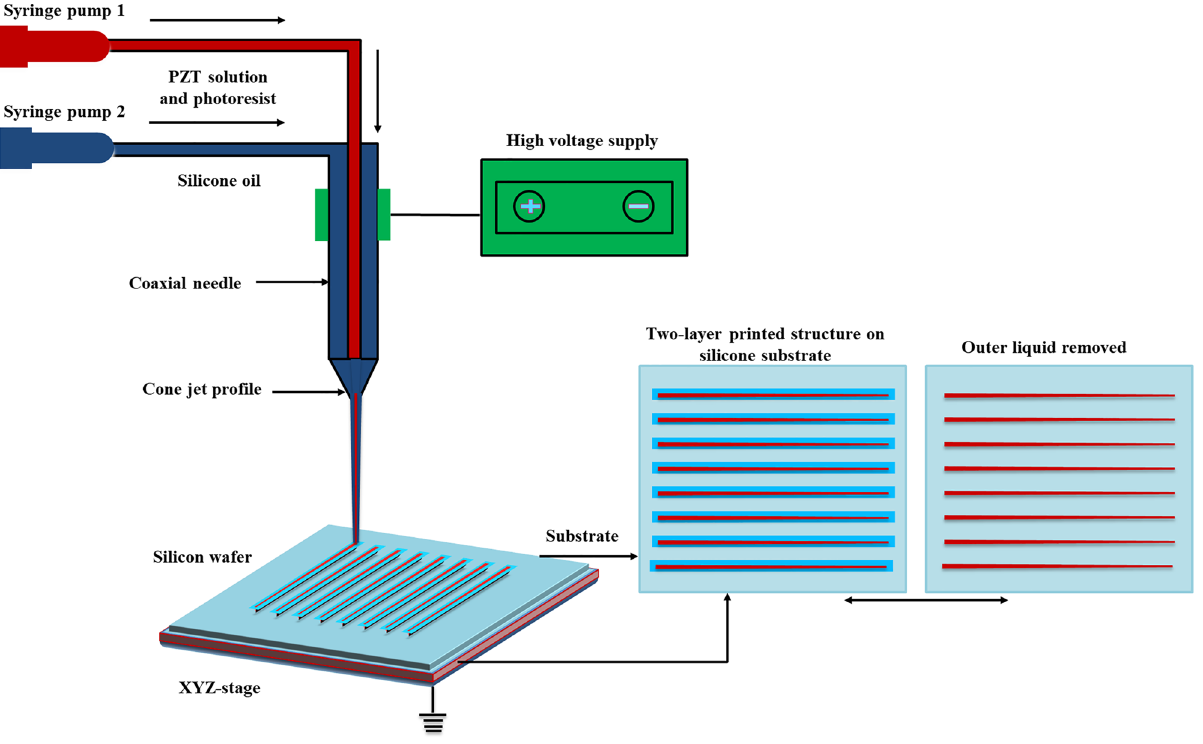
Figure 2. The schematic diagram of the CE-Jet printing system.